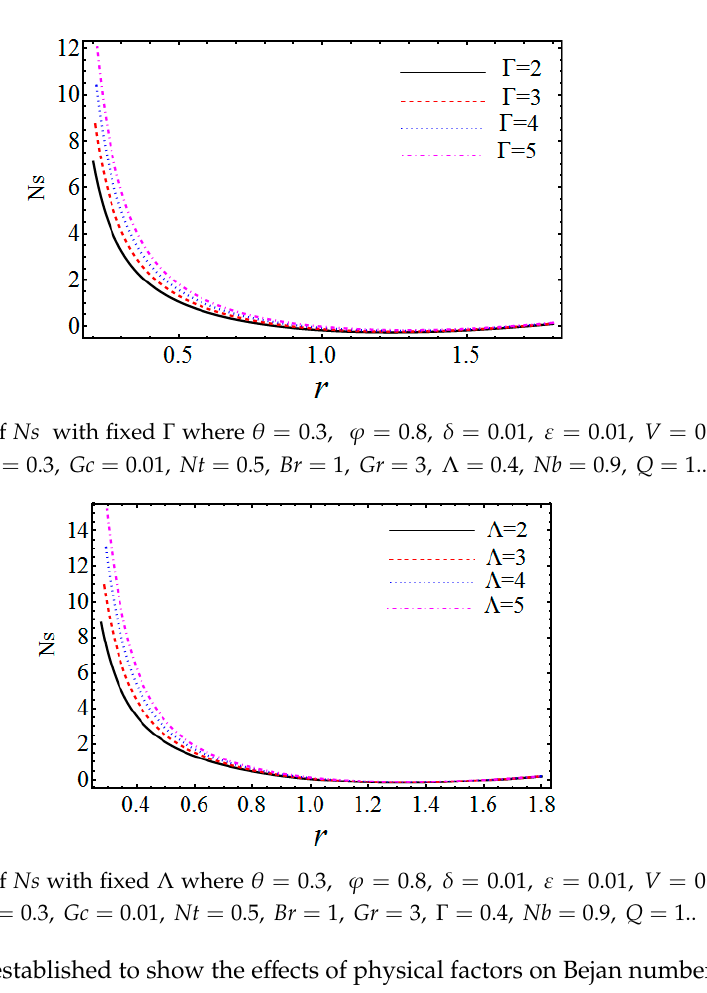
Figure 16. Curves of 𝑁𝑠 with fixed Ω where 𝜃 = 0.1, 𝜑 = 0.8,𝛿 = 0.01, 𝜀 = 0.01,𝑉 = 0.3, 𝜆 (cid:2869) = 1, 𝑧 = 0, 𝑡 = 0.1, Γ = 0.4,𝐺𝑐 = 0.01, 𝑁𝑡 = 0.5,𝐵𝑟 = 1, 𝐺𝑟 = 5, Λ = 1, 𝑁𝑏 = 0.9, 𝑄 = 1.